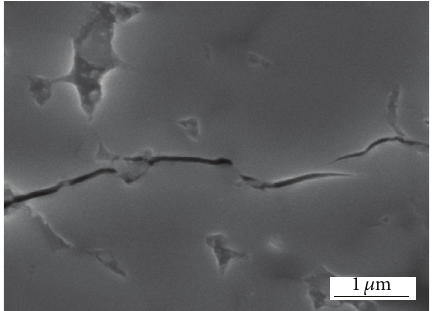
Figure 12: SEM image showing crack propagation of TaC/CNTs/SiC.